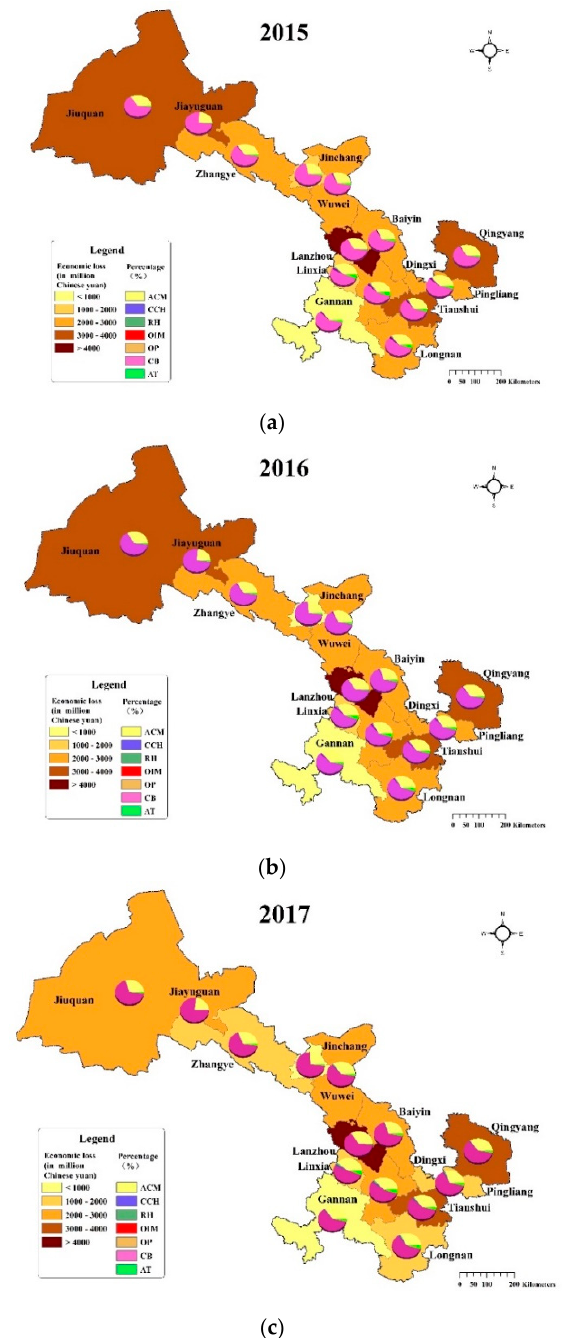
Figure 5. Economic loss of PM 2.5 -related health impacts in 14 cities in Gansu Province from 2015 to 2017.